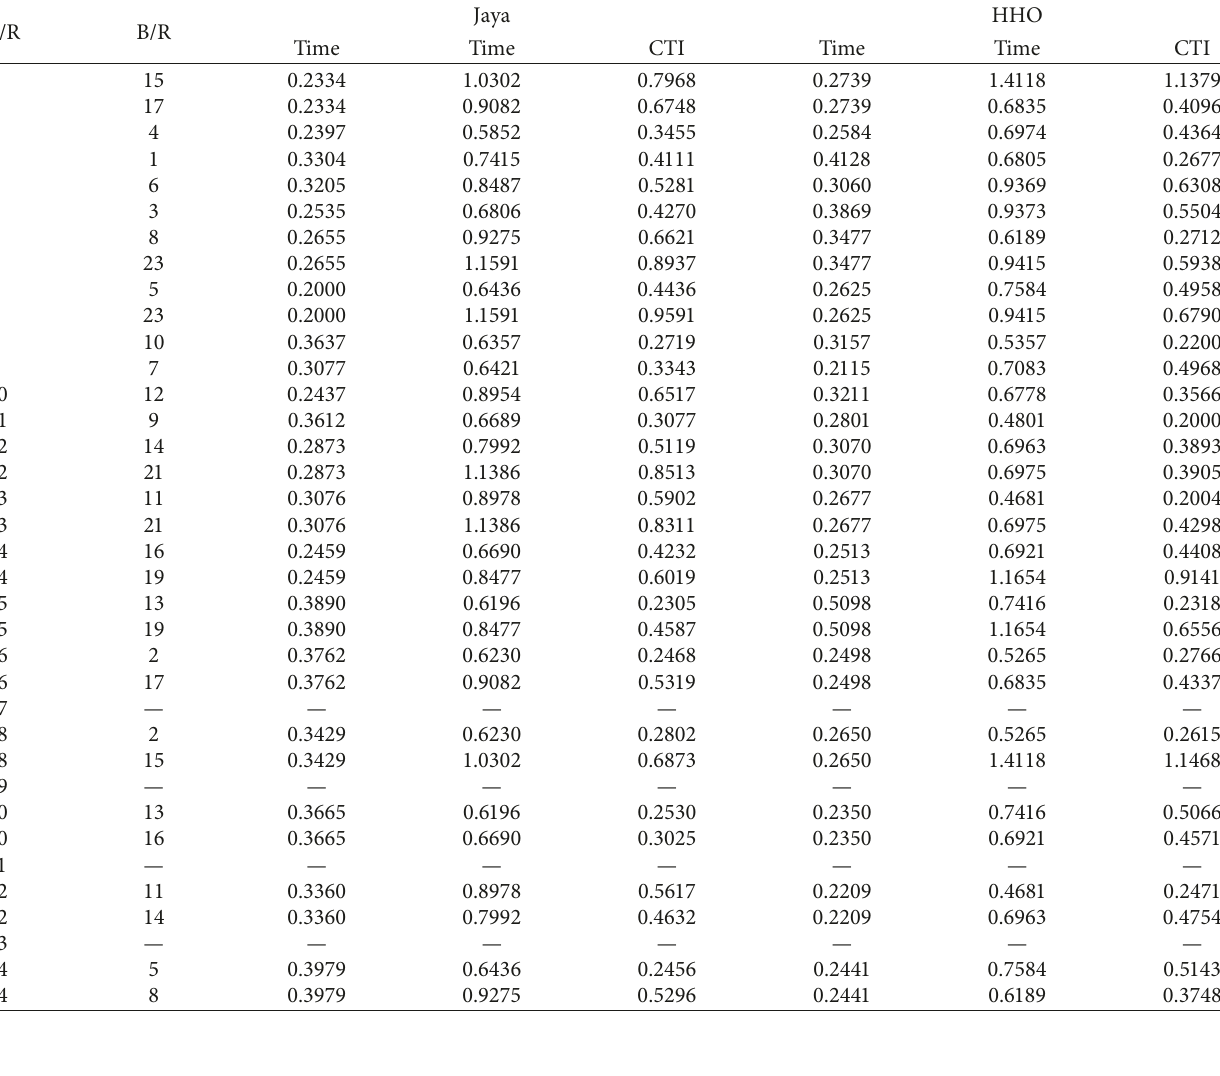
Table 16: Operating time and CTI for the 9-bus system by NLP formulation.